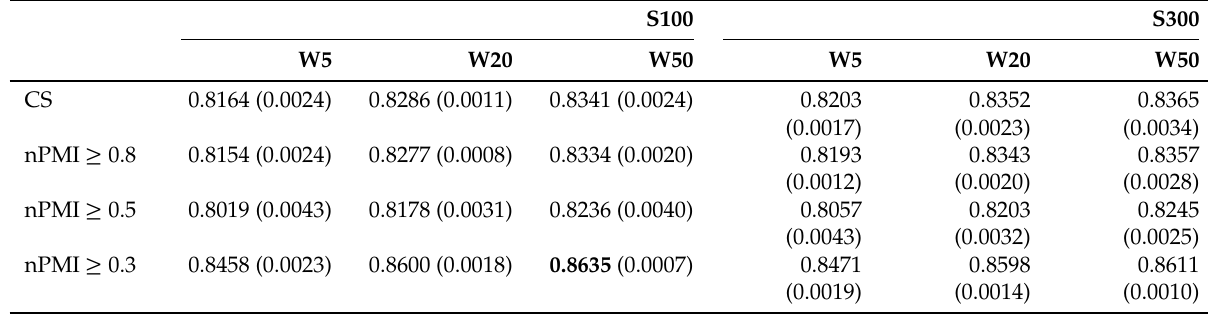
Table 6: Knowledge-based WSD accuracies (standard deviations) using CUI association values (MeSH term co- occurrences), CUI definitions (UMLS), and word